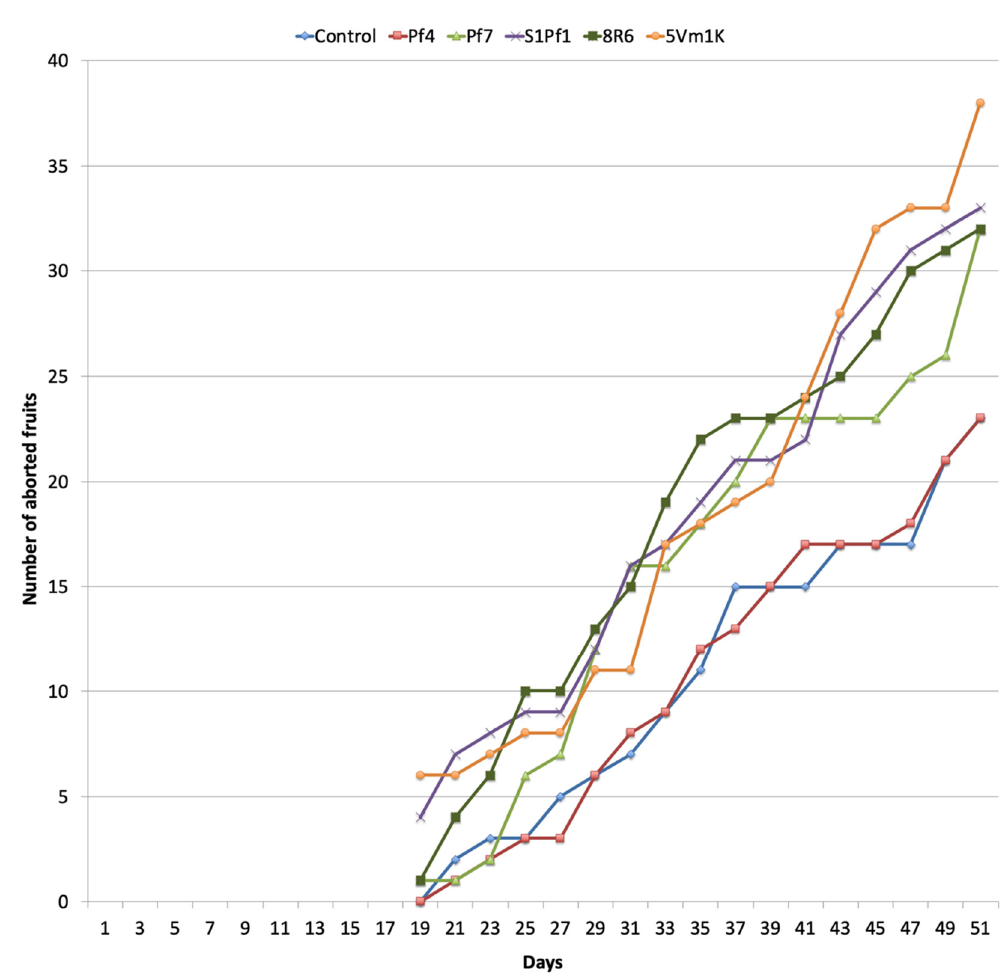
Figure 4. The number of aborted fruits produced by zucchini plants inoculated or not with the five PGPBs during two months of growth. The * indicates a sampling time where significant differences among the treatments were observed; in the table the different letters indicate significant differences among the treatments according to ANOVA followed by multiple comparisons of the means with the p -values adjusted according to the Bonferroni or to Kruskal–Wallis test followed by the Dunn test ( p < 0.05).